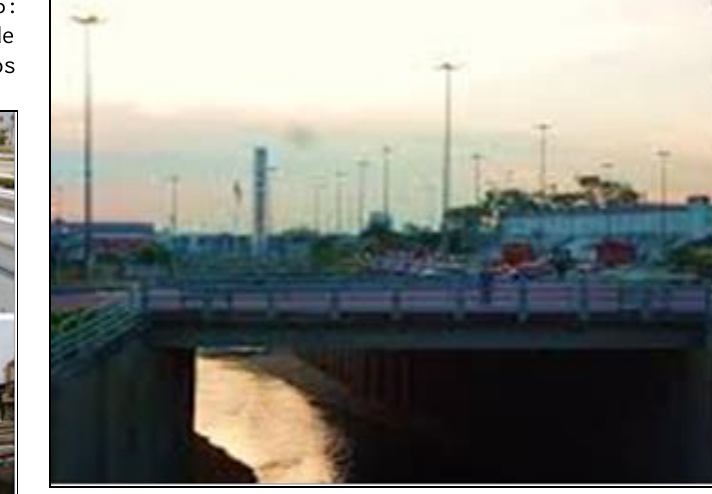
Figura 9: Igarapé do Quarenta ponte do bairro cachoeirinha. Fonte: Autores,